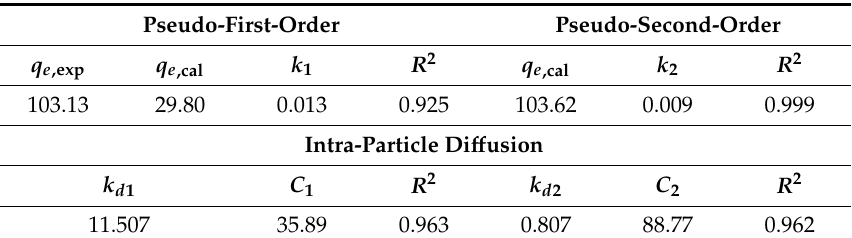
Table 2. Adsorption kinetic